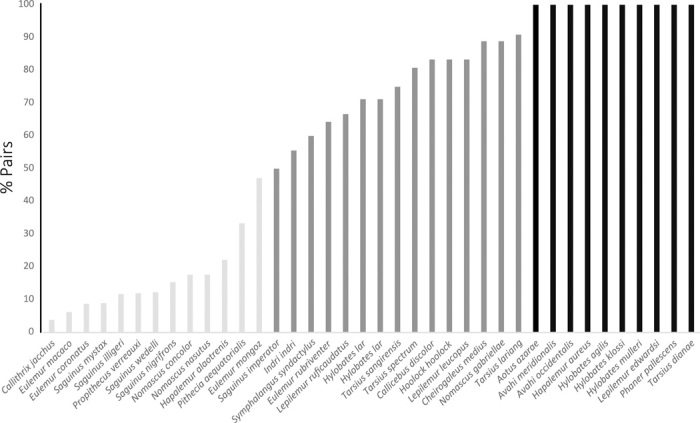
Proportion of pairs among primate social units with at least some pairs.Some species appear to be obligatorily pair living because all of their social units consists of only one pair of adults (black). In other species, more than 50%, but less than 100%, of social units consist of pairs (dark gray). The remaining species are characterized by not only a predominance of groups with three or more adults but also some pairs (light gray). Total sample size is 1081 social units from 38 species.